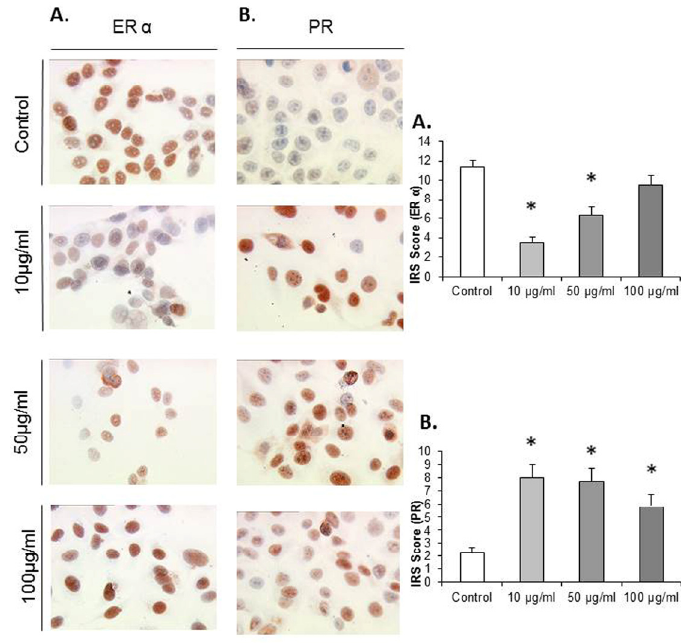
Figure 4. Representative microphotographs of MCF7 cells grown in the absence or presence of elder flower extract (at effective EFE concentrations of 10 µ g/mL, 50 µ g/mL, and 100 µ g/mL), after immuno-detection of ER- α ( A ) and PR ( B ); and presentation of the immunocytochemistry results by the semi-quantitative immunoreactivity score (IRS). Significantly different observations are highlighted with an asterisk.